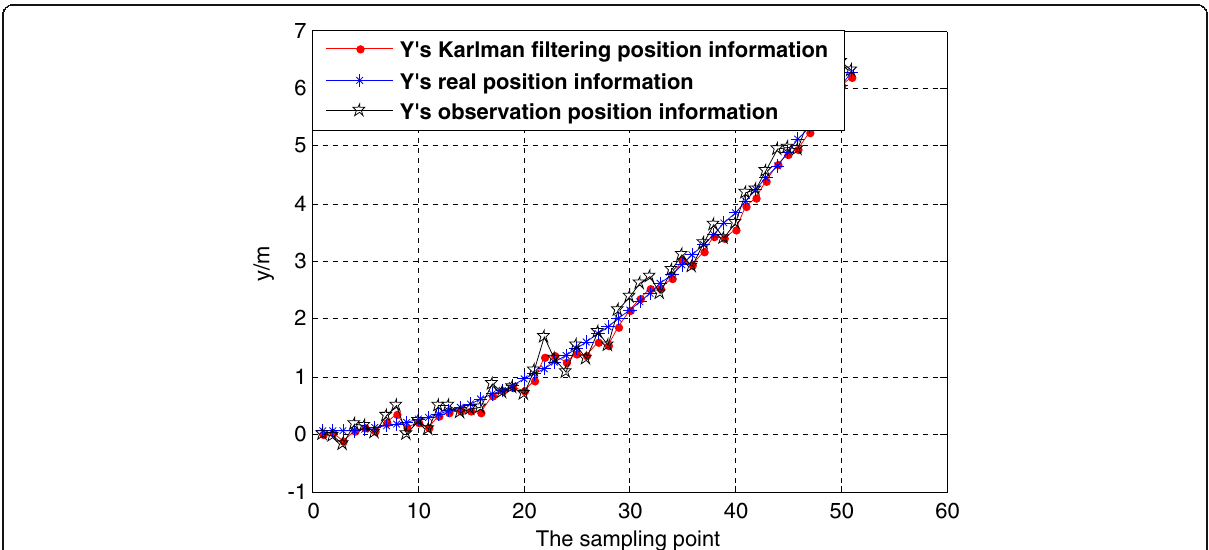
Fig. 11 Y orientation effect. It can be found from this figure the orientation effect of Y direction. Estimated curve for actual location estimation is more accurate and basically could reflect the actual status of robot at the moment, using Kalman filtering algorithm, and is used for